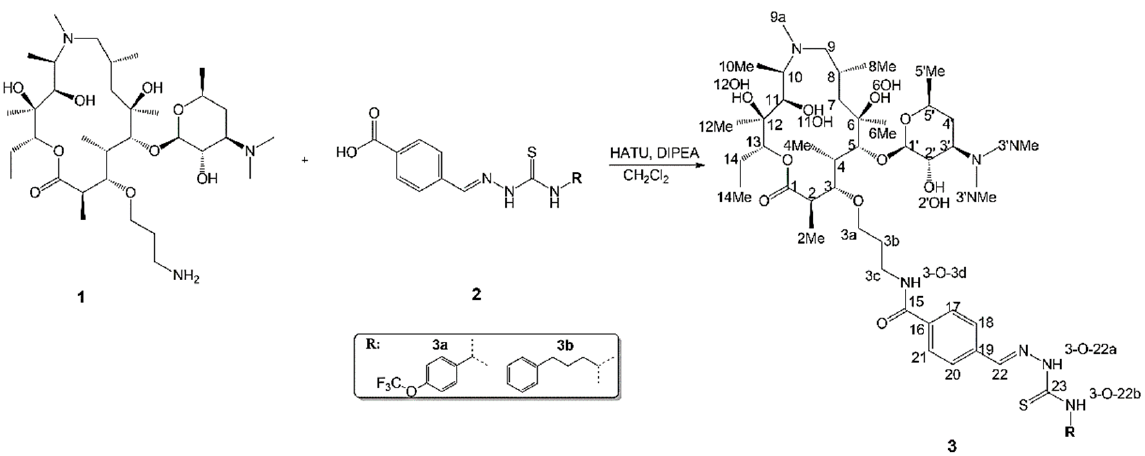
Figure 1. The final step in the synthesis of 3-macrozones.